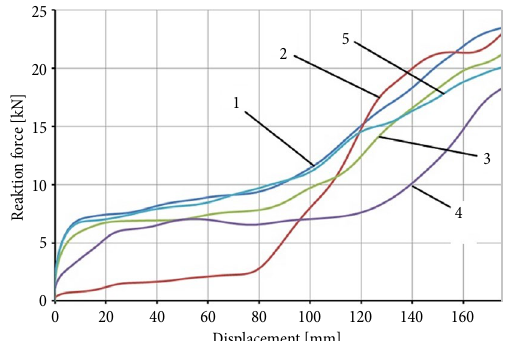
Fig. 6. Pillar reactions of a standard vehicle: 1 – full structure; 2 – without A-pillar; 3 – without front header; 4 – without side rail; 5 – without B-pillar